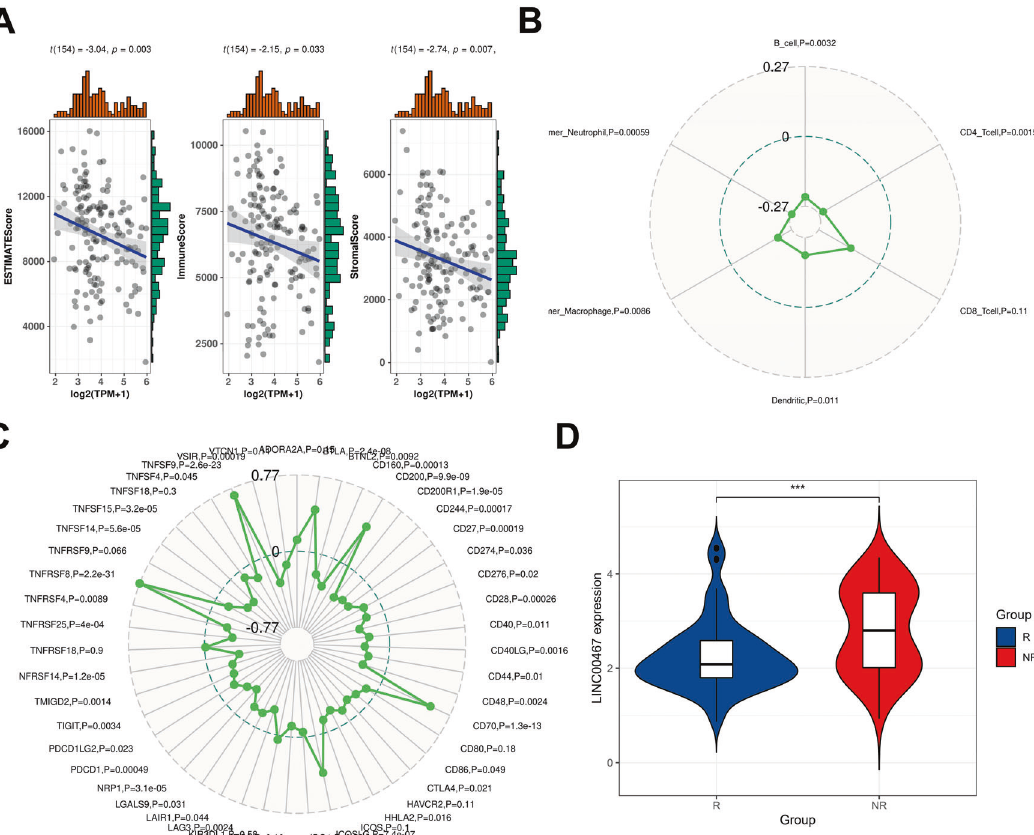
Fig. 7 LINC00467 is negatively correlated with TGCT immune in fi ltration. A Correlation of LNC0040067 expression with estimate score, immune score, and stromal score. B Correlation between LNC00467 expression and the degree of immune cell in fi ltration. C Correlation between LNC00467 expression and immune checkpoint gene expression. D Expression of LNC00467 in samples from the response and non- response to immunotherapy groups. R: response, NS: